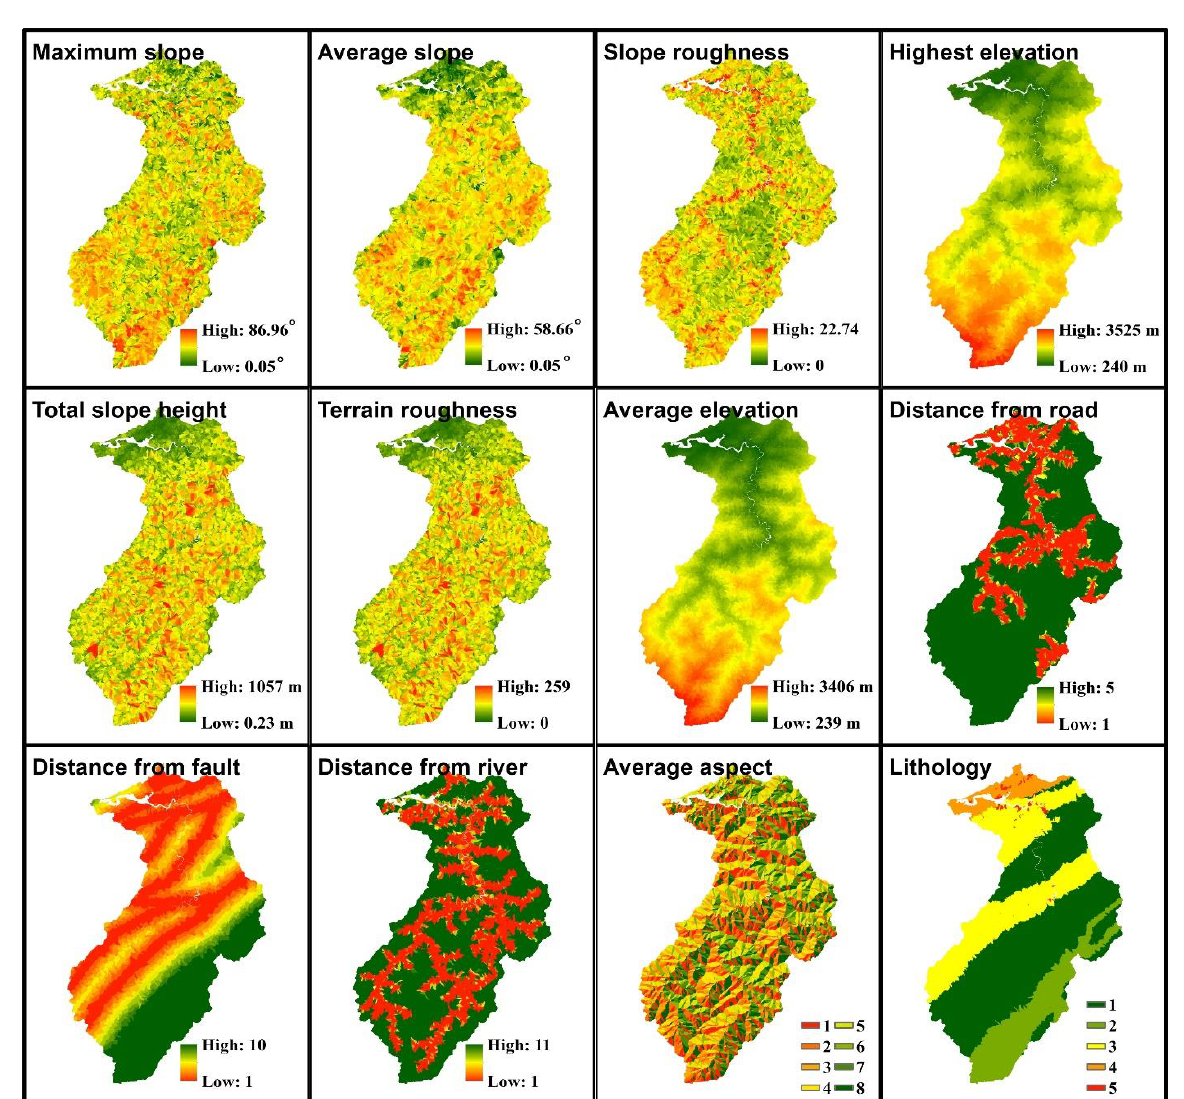
Figure A1. Maps of 12 topographic factors.